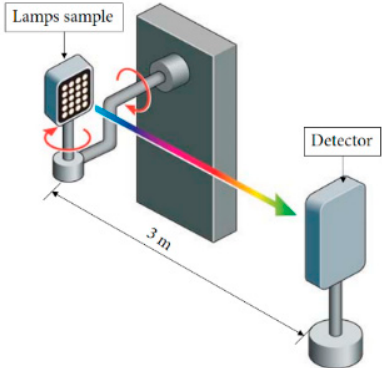
Figure 13. Optical experiment setup for optical intensity distribution testing.